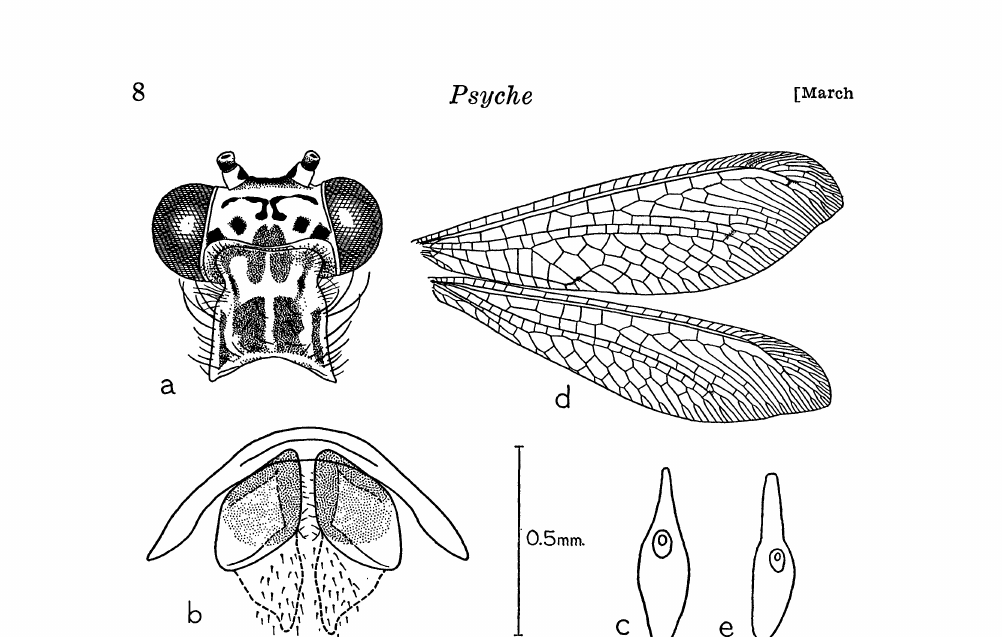
Fig. 1. Eremoleon cerverinus (Navas): a--vertex and pronotum, b mgonarcus and parameres, c Mlast segment, labial palpus. E. sectoralis n. sp.: drawings, elast segment, labial palpus. Scale for figs. b, c, e